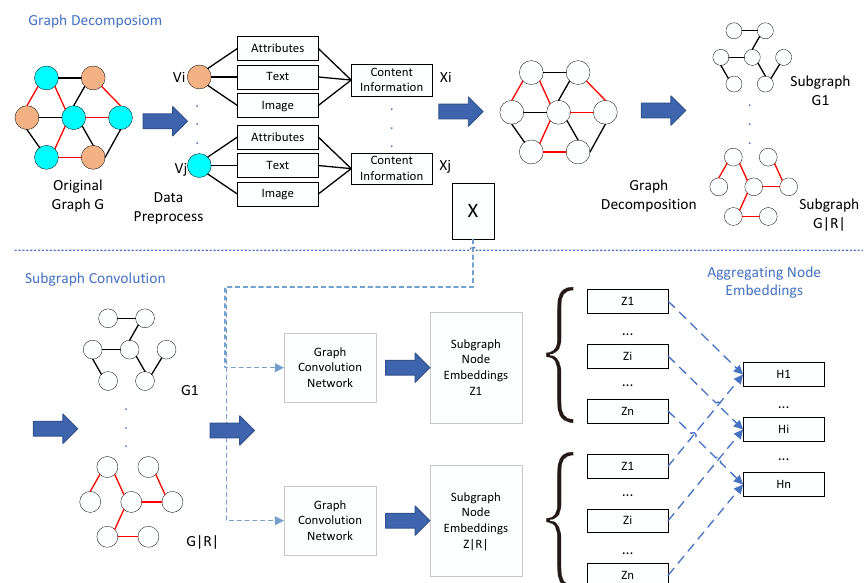
Figure 2. MSGCN model: We first preprocess the node content information, so that they have the same dimension. Then the original graph can be decomposed with respect to the type of edges. For each subgraph, we use graph convolution to get the node representations. Finally, an aggregation operation is applied to get the final